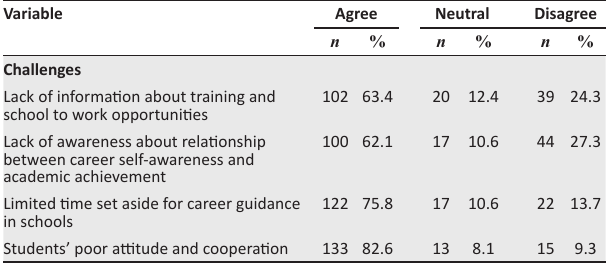
TABLE 3: Students’ responses about challenges faced during the implementation of career guidance and counselling